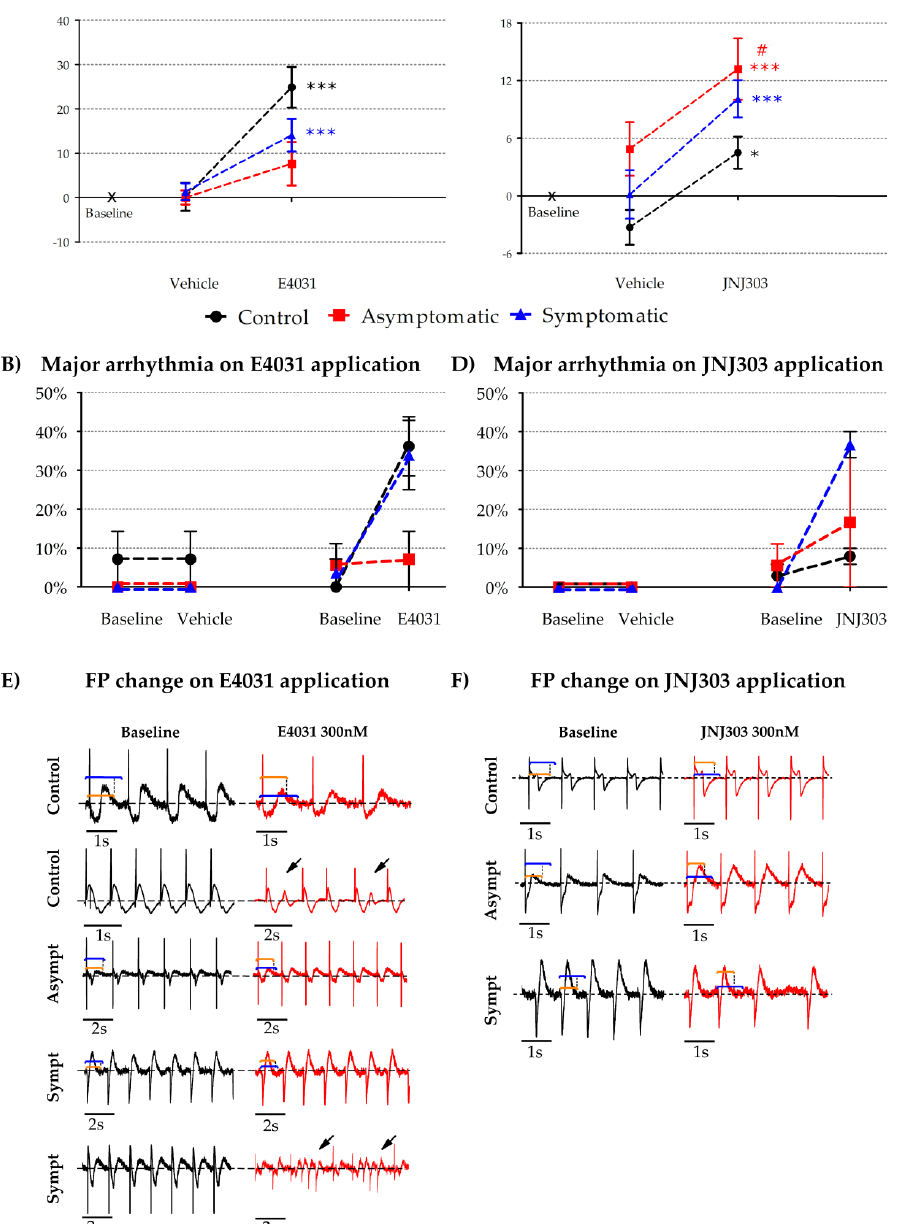
Fig 5 Figure 5. The e ff ects of the IKr and IKs blockers ( A , B ) The plots show the responses of the control, the LQT2 asymptomatic and the symptomatic hiPSC-CM aggregates to the IKr blocker E4031 at 300 nM and the occurrence of major arrhythmia for the vehicle (distilled H 2 O) n = 26, 18, 19 respectively, and for 300 nM E4031 n = 39, 17, 24, respectively. ( C , D ) Responses of the control, the LQT2 asymptomatic and the symptomatic hiPSC-CM aggregates to the IKs blocker JNJ303 300 nM and the occurrence of major arrhythmia for the vehicle (DMSO) n = 9, 3, 11, respectively, and 300 nM JNJ303 n = 27, 13, 12, respectively. Data is presented as mean ± SEM, (*) p < 0.05 and (***) p < 0.001 compared between Long QT asymptomatic or symptomatic and control and (#) p < 0.05, compared on all three lines by ANOVA. ( E , F ) Representative field potentials and the characteristic arrhythmia observed in the control, the LQT2 asymptomatic and the symptomatic hiPSC-CM aggregates at baseline (black) and after application of E4031 and JNJ303 (red); the prolongation in FPD is marked by orange and blue lines, whereas EAD-like arrhythmias and premature ectopic beats (PEBs) are marked with black